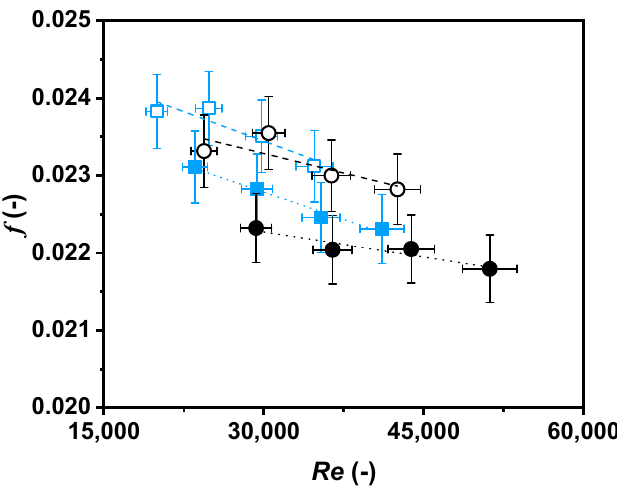
Figure 9. Nusselt number as a function of Péclet number for water (black) and nanofluid (blue) at 308.15 K ( ○ , ☐ ) and 318.15 K ( ● , ■ ).